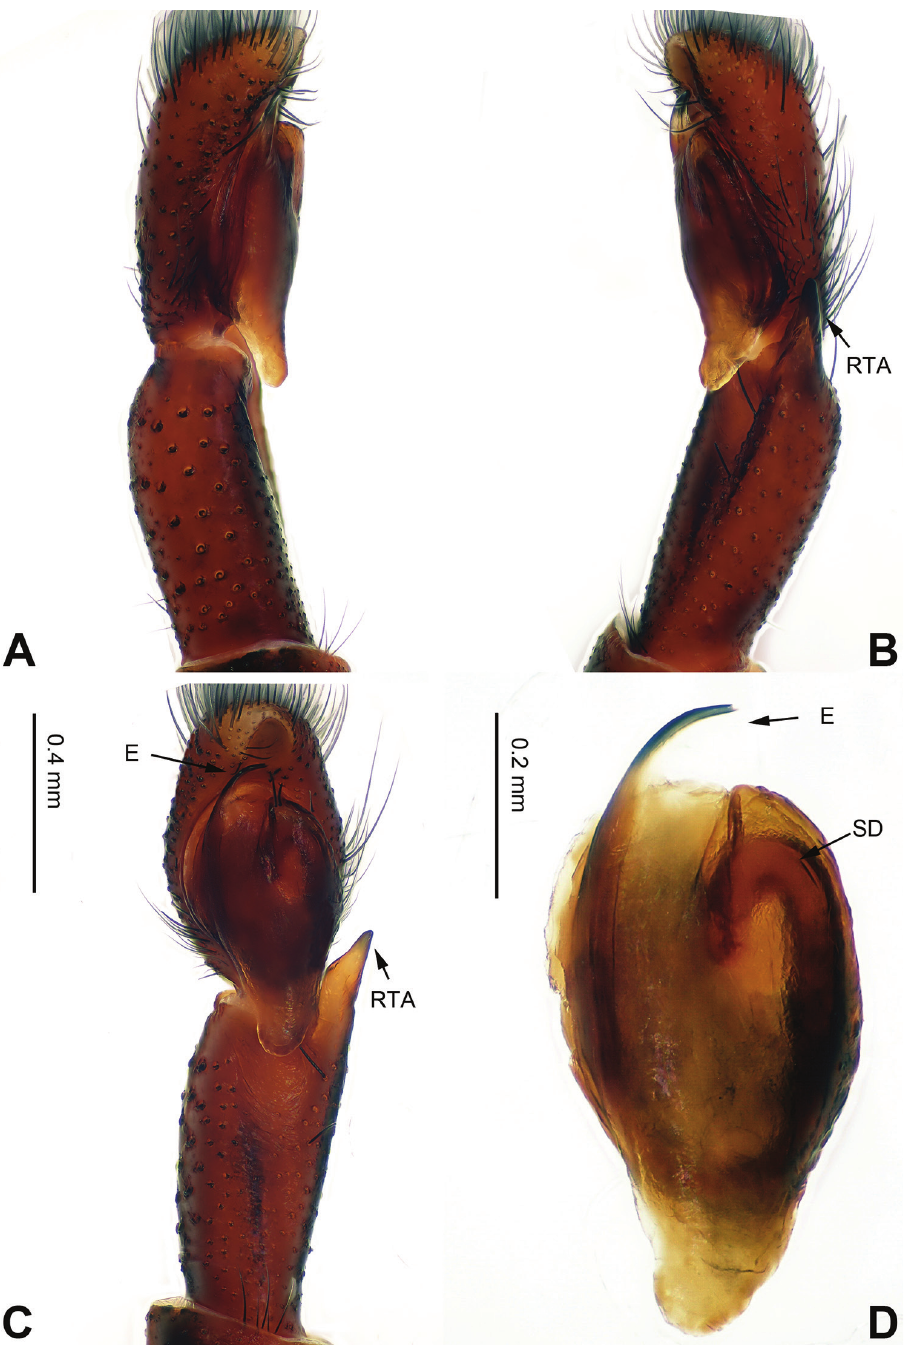
Figure 11. Palp of Carrhotus sarahcrewsae sp. n., male holotype. A prolateral B retrolateral C ventral D bulb, ventral. Scale bar equal for A–C